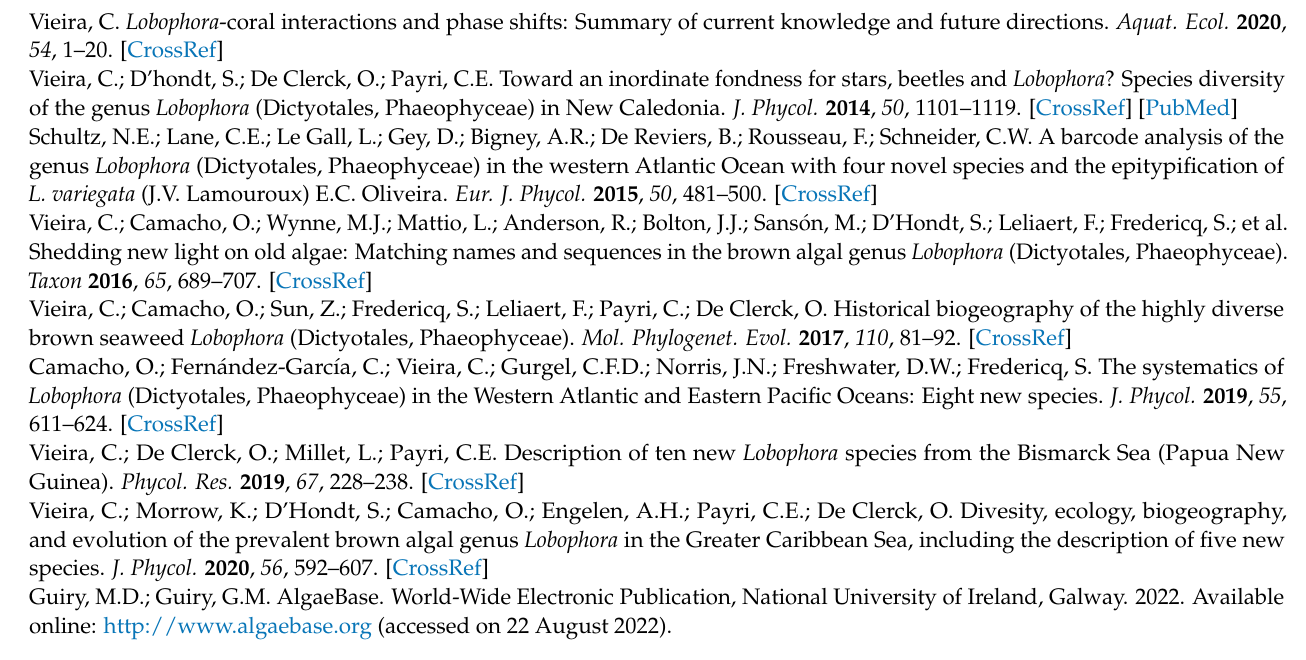
Figure S2. Specimen-level maximum likelihood (PhyML) phylogenetic tree of the brown algal genus Lobophora (Dictyotlaes, Phaeophy: Figure S3. Specimen-level maximum likelihood (PhyML) phylogenetic tree of the brown algal genus Lobophora (Dictyotlaes, Phaeophy: Figure S4. In situ photographs of interaction between Lobophora and corals: Figure S5. Map of sampling sites: Figure S6. Relationships between two features from hierarchical cluster analysis based on the clustering: Table S1. Interactions between Lobophora species and scleractinian corals in the study sites: Table S2. Algal specimens detials in this study: Table S3. Primers, PCR and sequencing conditions: Table S4. Voucher and GenBank accession data for additional specimens used for phylogenetic reconstructions: Table S5. Distance matrix of Lobophora species with Euclidean method